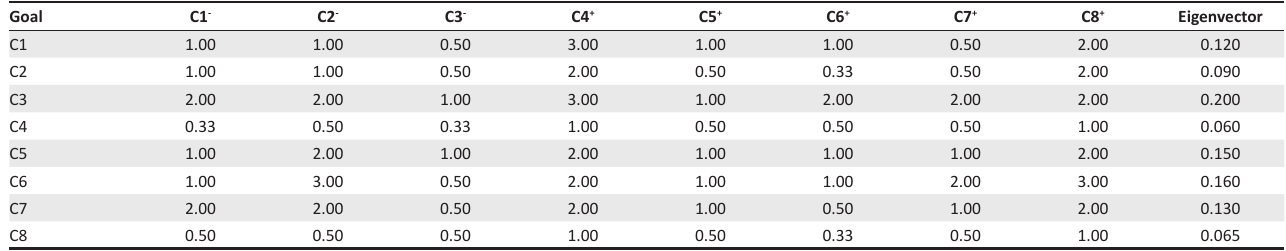
FIGURE 2: Location of collection centres. TABLE 1: Weights of criteria.